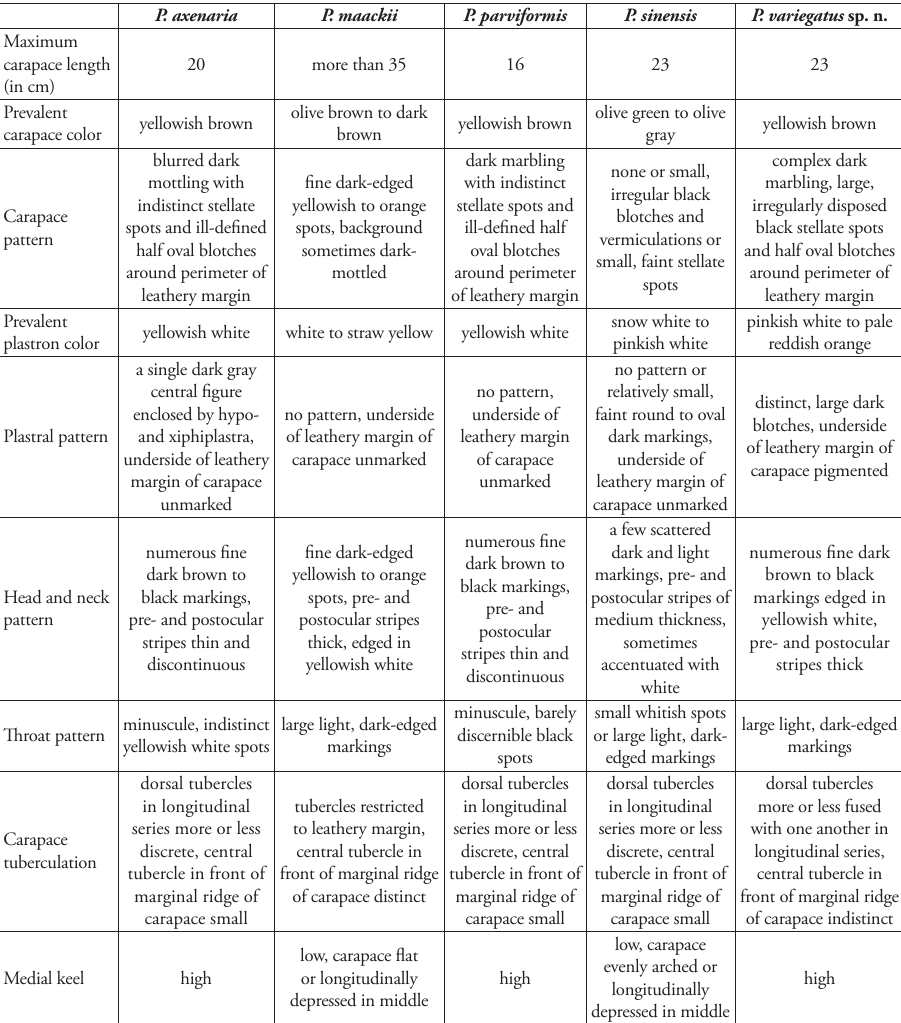
Table 4. Diagnostic morphological features of adults of Pelodiscus